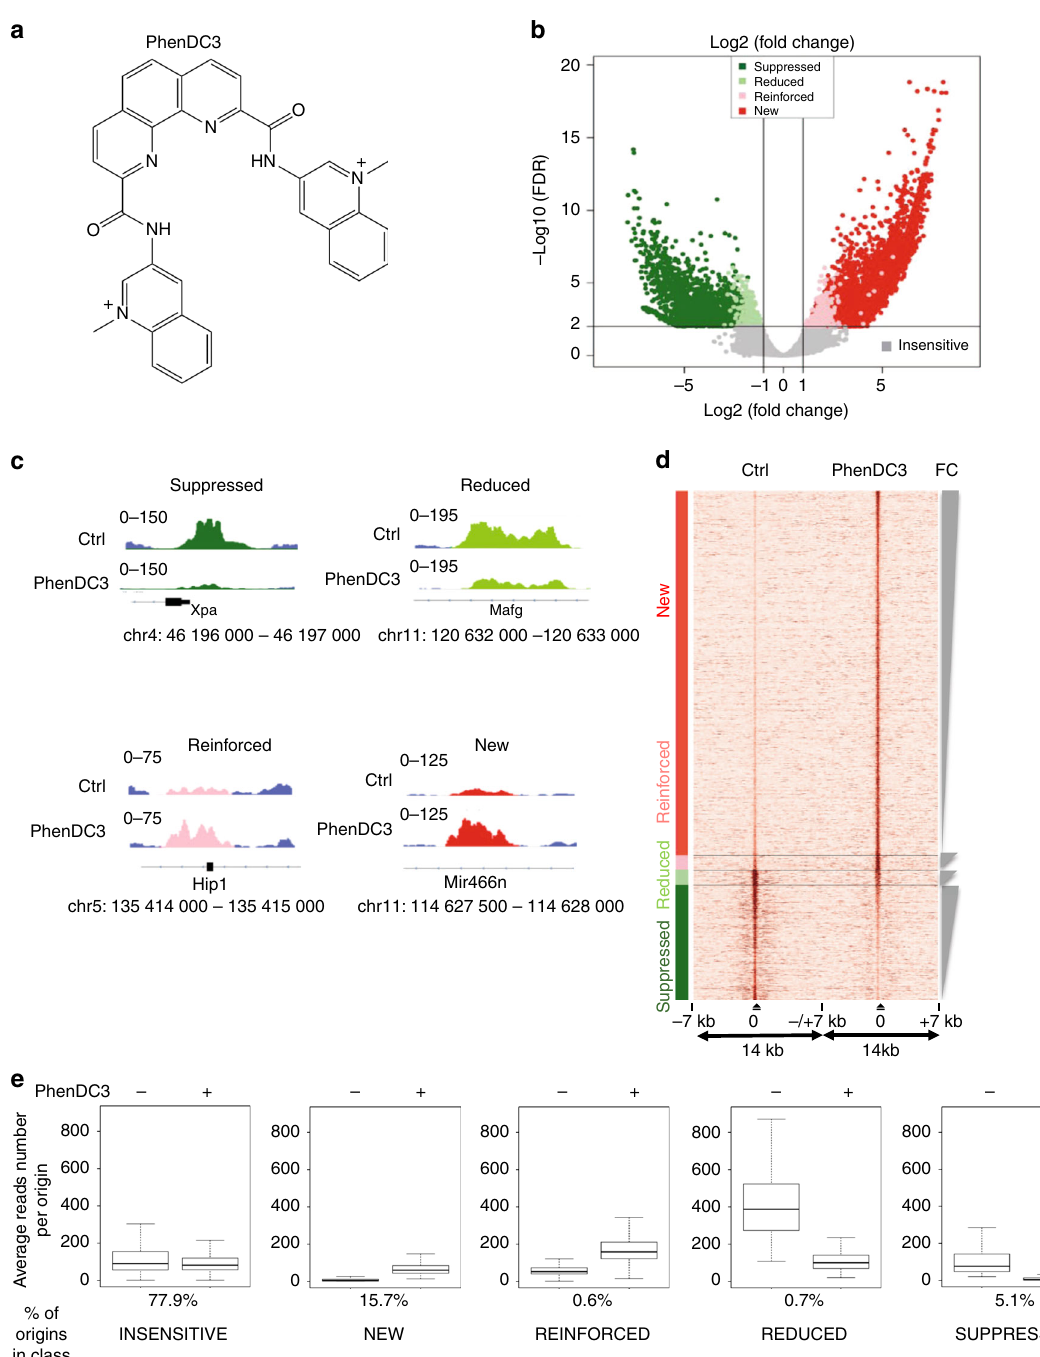
Fig. 3 Changes in the replication origin repertoire upon G4 stabilization by PhenDC3. a PhenDC3 formula. b Volcano plot of origins affected by incubation of mouse ES cells with PhenDC3. After identi fi cation of the bound sites in all SNS-seq samples, differential binding analysis was performed. For each origin, the corrected p values (false discovery rates, − log10(FDR)) and the log2 fold change (FC) of control and PhenDC3-treated samples were plotted. The horizontal and vertical lines correspond to the thresholds for detecting differential origins. On the basis of the FC and peak reproducibility, origins were classi fi ed in fi ve different classes, according to PhenDC3 effect ( suppressed, reduced, reinforced, new, and insensitive ), as described in “ Methods ” section. c Examples of the activity of origins in the indicated classes after incubation with PhenDC3 or in control cells. The corresponding genomic region is indicated and the origin color is according to the corresponding class in the Volcano plot. d Heatmap showing the read densities in origins affected by G4 stabilization (PhenDC3-treated vs. Control). The heatmap indicates the signal strength (number of reads) and density around each origin and was performed on 7 kb regions on each side of origins, as previously described 4 . The intensity (brown) is proportional to the read counts per 100 bp bins. Origins were sorted on the basis of the FC in signal strength. e Activity of origins (reads number) in each class in control ( − ) and